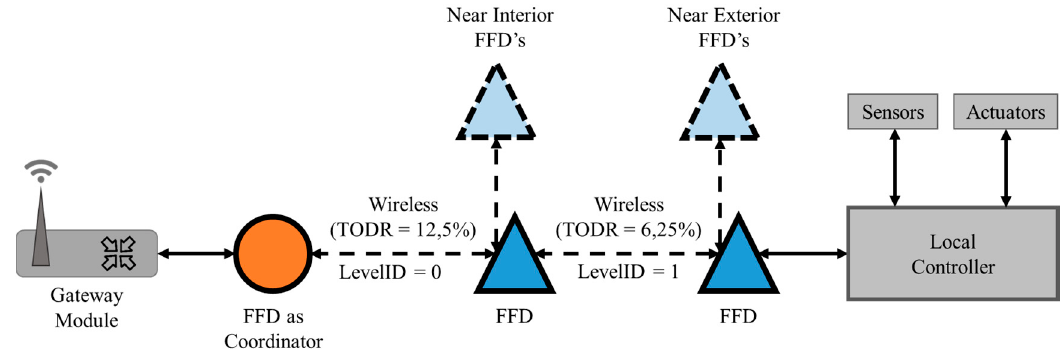
Figure 20. Manufacturing cell exterior connections example diagram with TODR values.